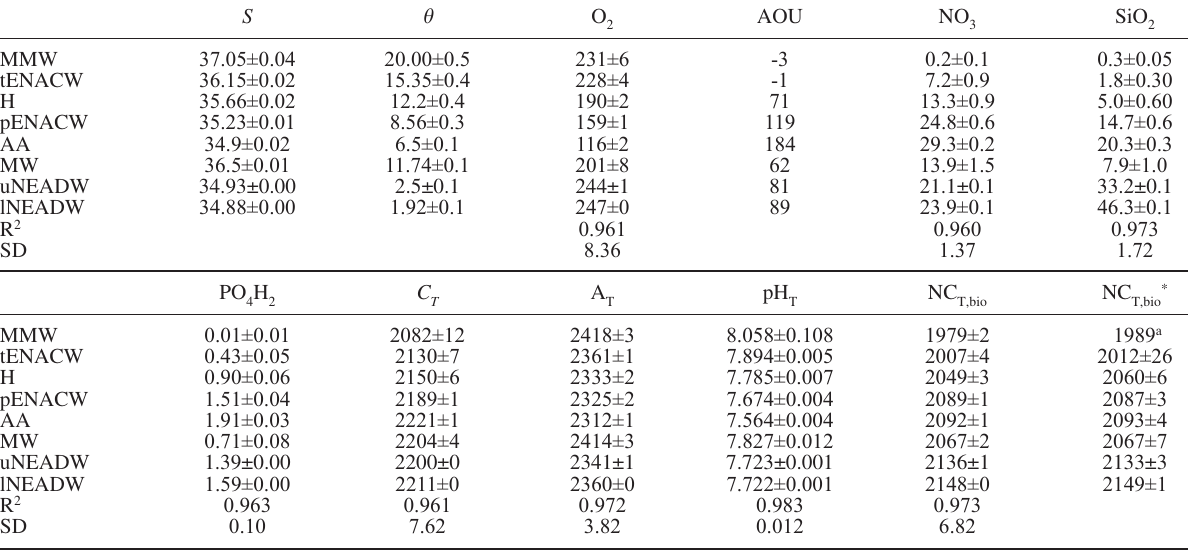
samples. Errors in S and θ after Álvarez et al. (2005). S θ O